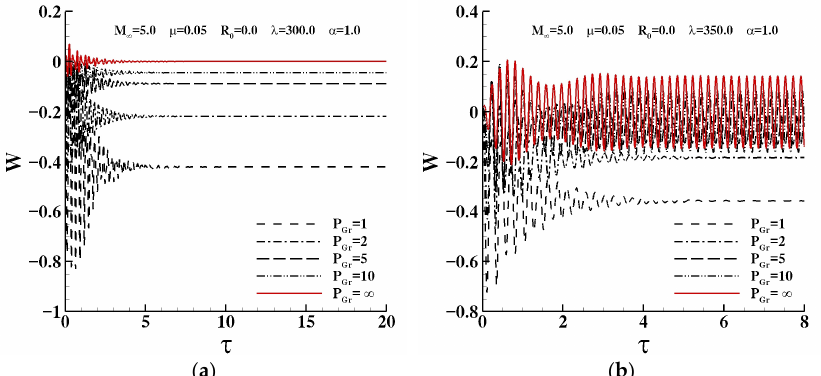
Figure 4. Time history of panel response under different pressure drop ratios: ( a ) λ = 300; ( b ) λ = 350.